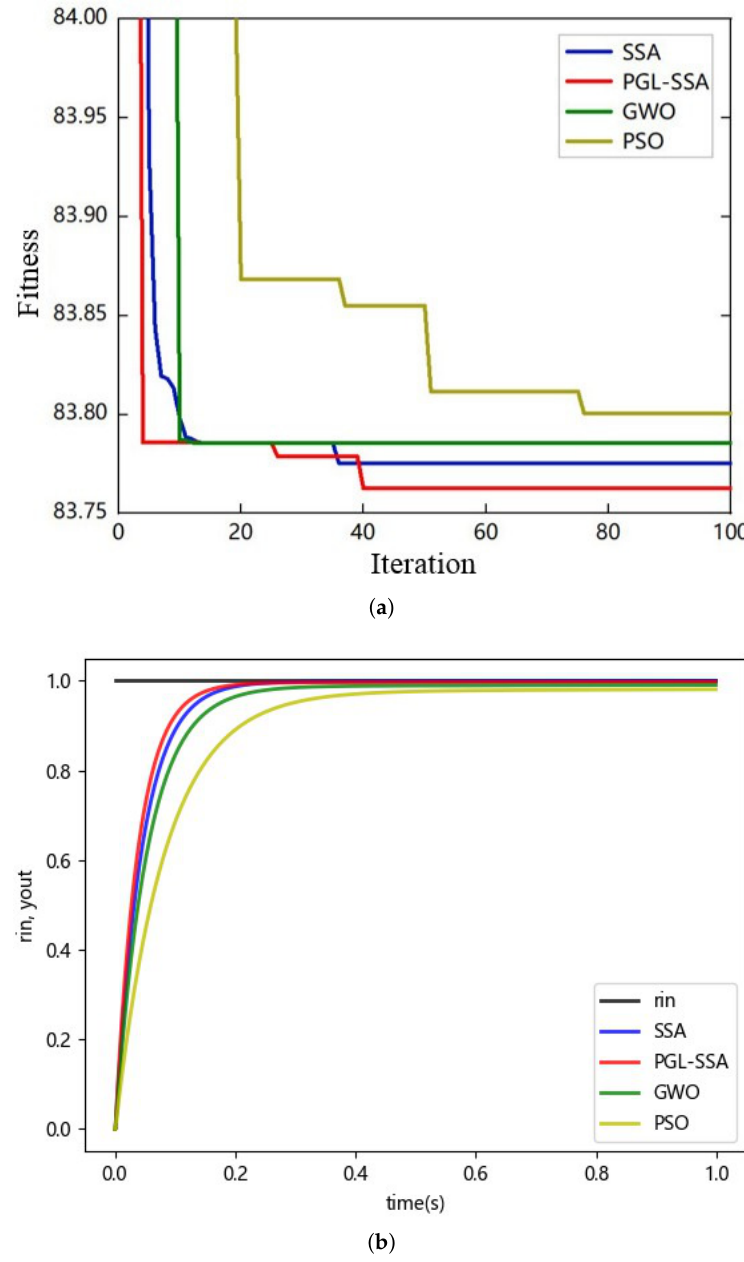
Figure 10. Convergence curves and step response curves of different algorithms for first-order inertial delay systems. ( a ) Convergence curve. ( b ) Step response